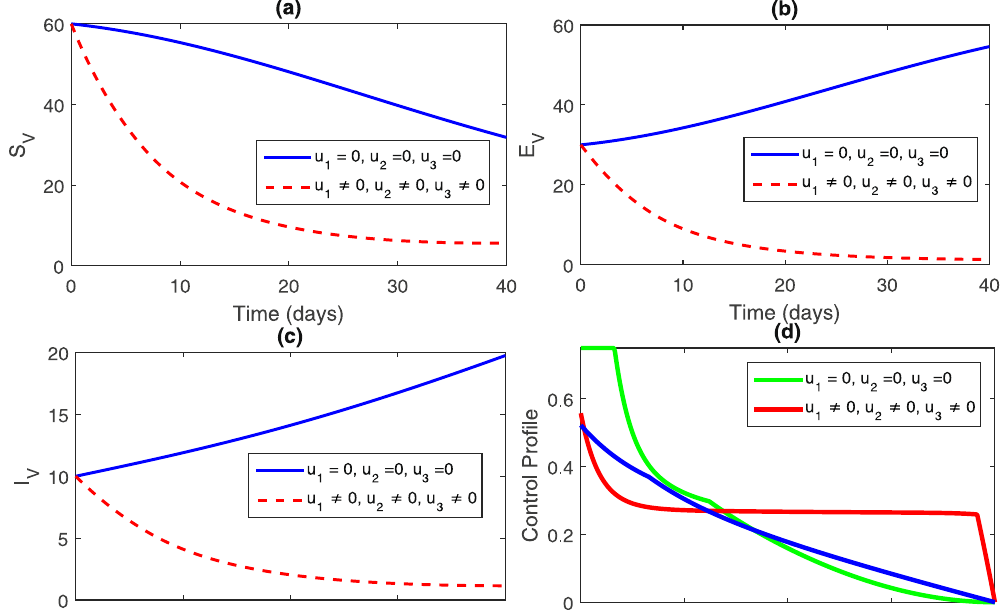
Figure 9. Comparison of both the systems: without and with